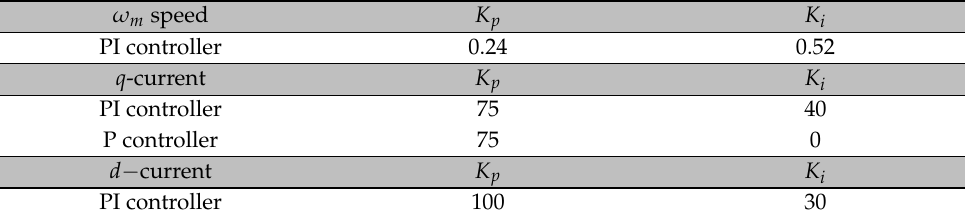
Table 3. Controller parameters for IRFOC